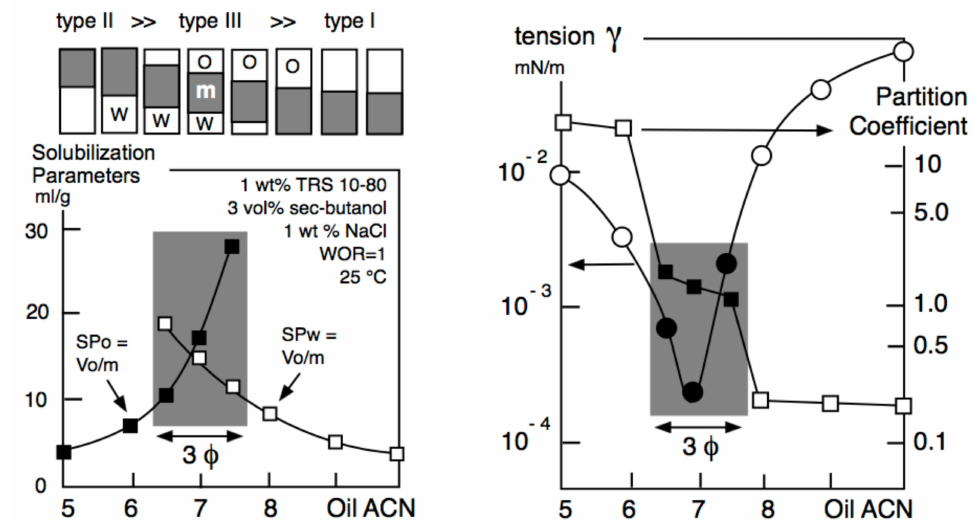
Figure 3. Optimum formulation has been shown in the very first trials [26] to correspond to the minimum interfacial tension and to a unit partition coe ffi cient between oil and water excess phases (right plot), as well as the occurrence of a maximum solubilization, with equal solubilization parameters (SP) in the microemulsion middle phase (left